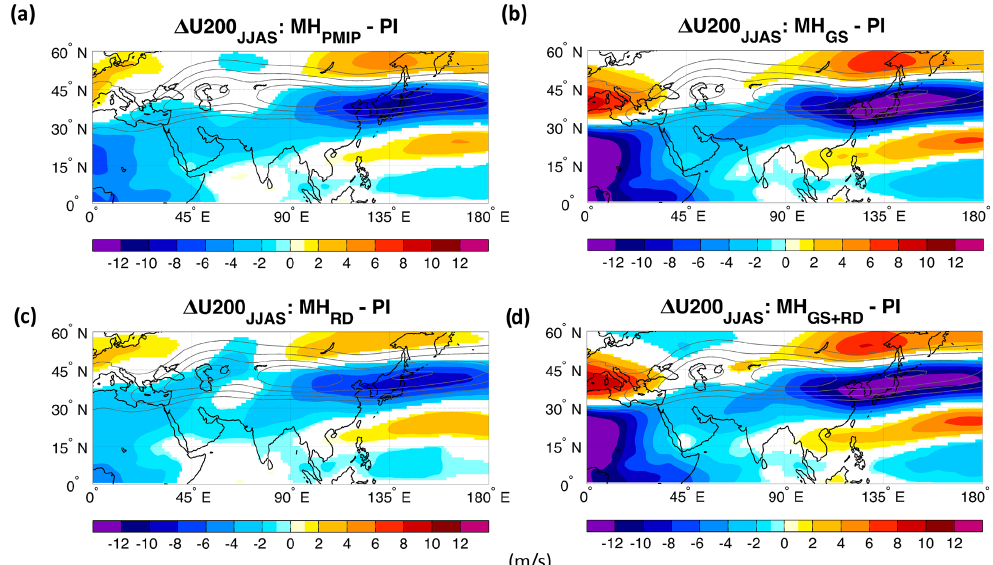
Figure 12. Changes in summer (JJAS) zonal wind at 200hPa (U200; m/s) for the (a) mid-Holocene-only orbital forcing (MH PMIP ); (b) the Sahara greening (MH GS ); (c) the dust-only reduction (MH RD ); and (d) the Sahara greening and dust reduction (MH GS + RD ) experiments relative to the PI reference simulation. The contour lines show the climatological summer zonal wind at 200hPa for the PI experiment. Only differences significant at the 95% confidence level using the Student t test are